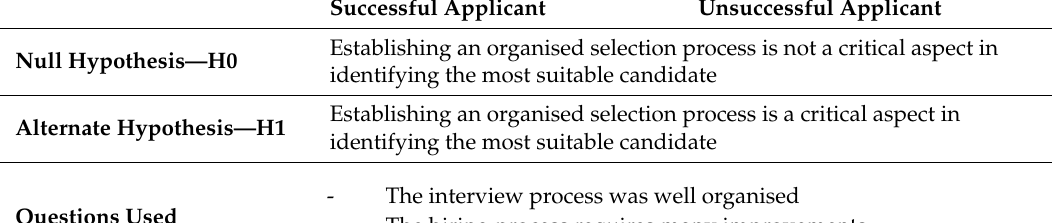
Table 6. Applicant Perspective Hypothesis 4—Organised selection interview process.